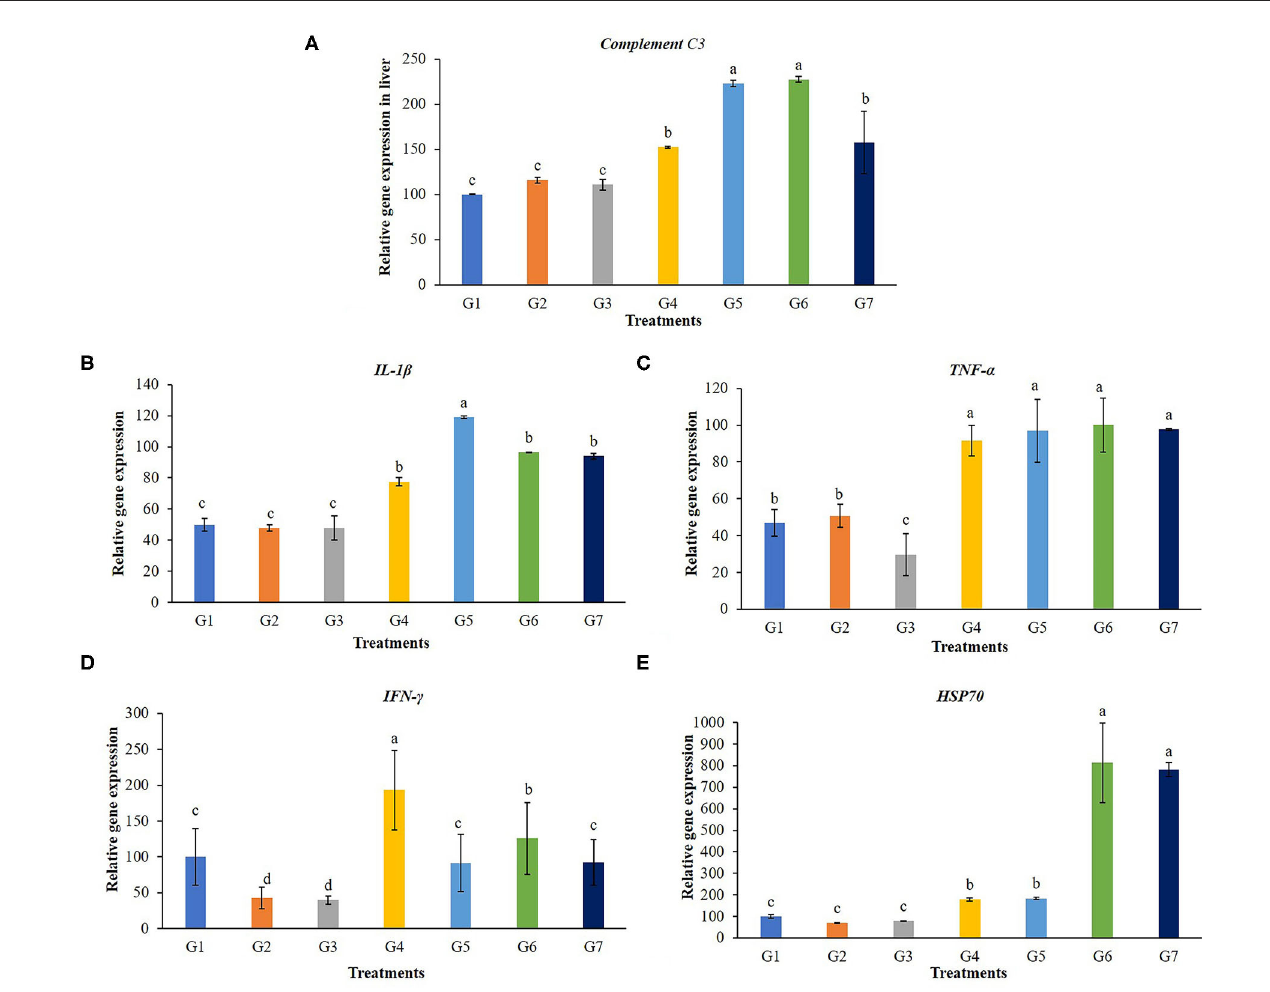
FIGURE5 Gene expression in the liver of complement C3, interleukin 1beta ( IL-1 β ), tumor necrosis factor ( TNF- α ), interferon gamma ( IFN- γ ) and heat shock protein 70 ( hsp70 ) of Nile tilapia fed with FOS and B. subtilis for 56 days. (A) Complement C3, (B) Beta ( IL-1 β ), (C) tumor necrosis factor (TNF- α ), (D) interferon gamma ( IFN- γ ), and (E) heat shock protein 70 ( hsp70 ).